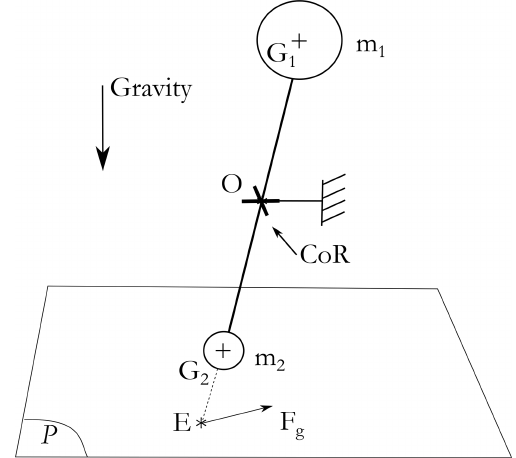
Figure 14. Simplification of the gravity compensation model.